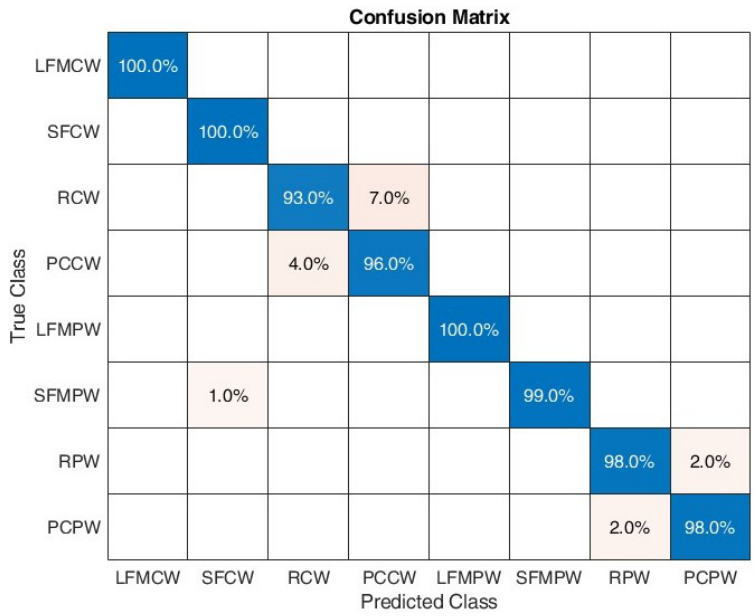
Figure 17. Confusion matrix for SNR in range [ − 5:0] dB.